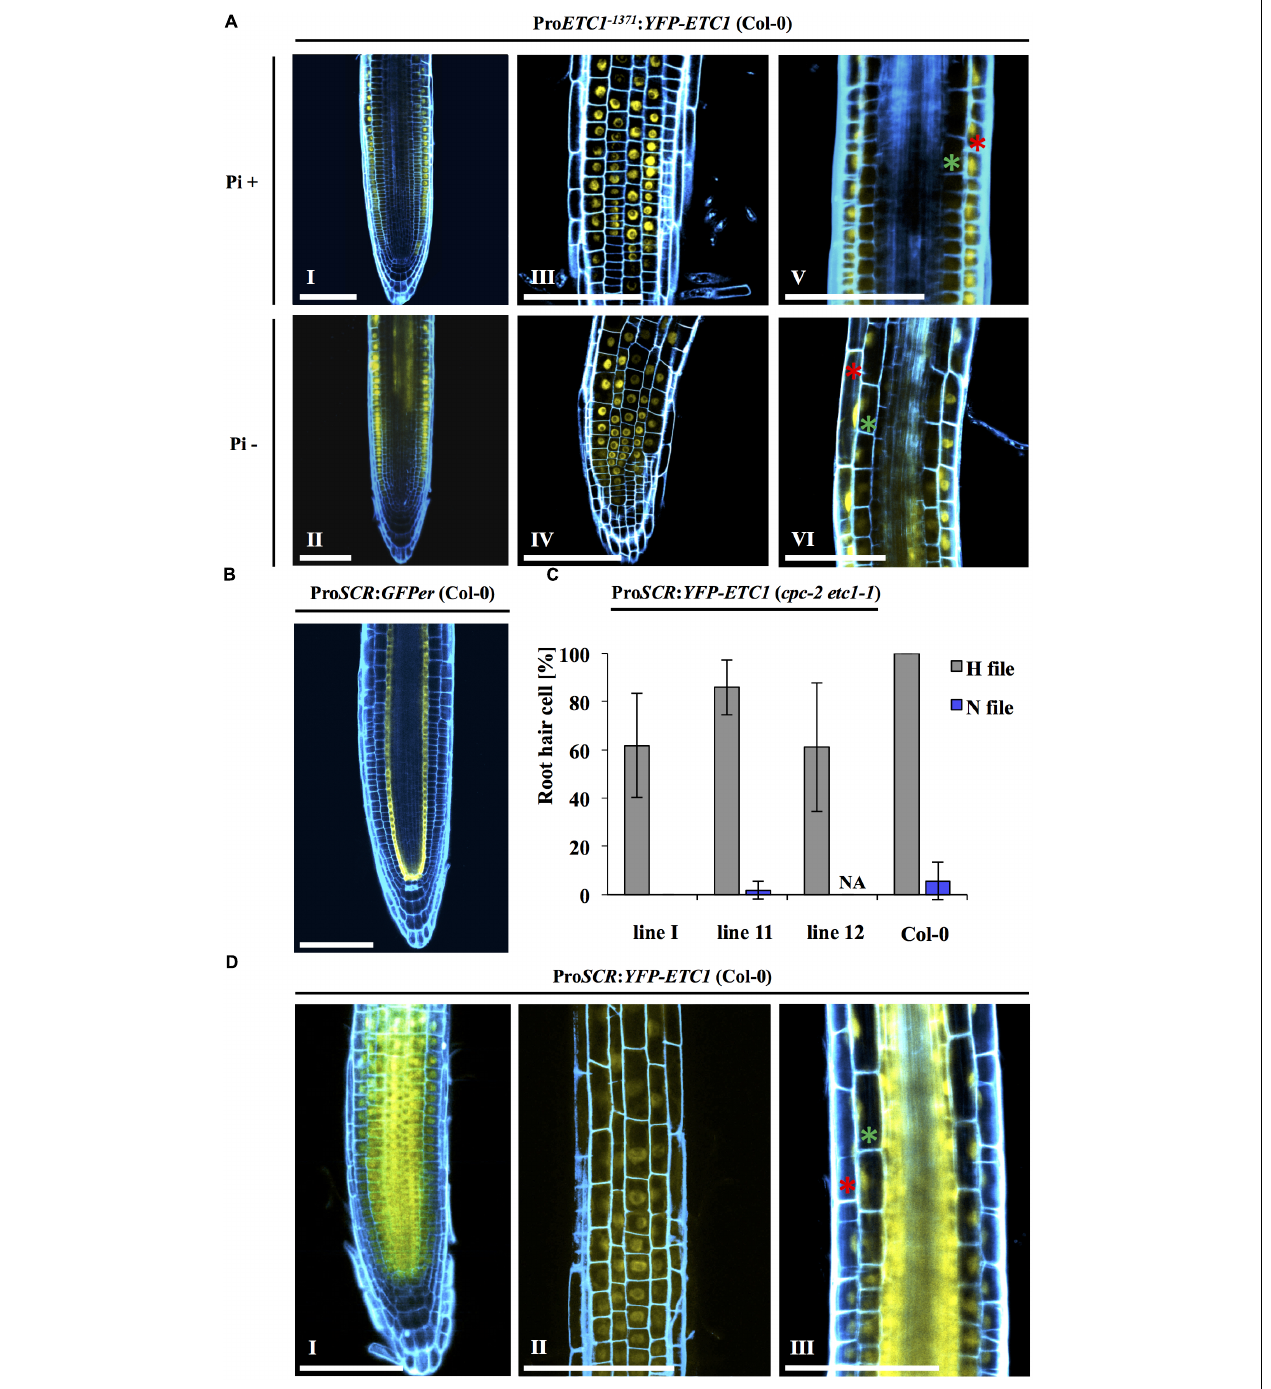
FIGURE 5 | Intercellular motility and localization of YFP-ETC1 under the ETC1 and SCR promoters. (A) Root of a cpc-2 etc1-1 double mutant plant carrying Pro ETC1 : YFP-ETC1 under Pi+ and Pi– conditions. Under Pi+ conditions, YFP-ETC1 is seen in the root hair and non-root hair file epidermal cells (I, III) but not in the ground tissue (V). Under Pi– conditions, YFP-ETC1 was observed in the root hair and non-root hair file epidermal cells (II, IV) and in the ground tissue (VI). (I, II) Pictures show overview, (III, IV) pictures show focal planes of the epidermis and (V, VI) pictures show the focal planes in the cortical cells and the stele. Red stars mark epidermal cells, green stars mark cortical cells. Scale bar = 100 µ m. (B) CLSM pictures of roots from transgenic Pro SCR:GFPer (Col-0) plants grown under Pi+ conditions. Blue: propidium iodide, yellow: YFP. (C) A diagram showing the rescuing ability of Pro SCR:YFP-ETC1 in the cpc-2 etc1-1 double mutant under Pi+ conditions. (D) Pro SCR:YFP-ETC1 (Pi+ conditions). (I) Overview shows YFP-ETC1 in all tissues. (II) Focal plane showing YFP-ETC1 in epidermal cells. (III) Focal plane showing YFP-ETC1 in the epidermal cells and the ground tissue. Red star labels an epidermal cell, green star labels a cortical cell. Scale bar = 100 µ